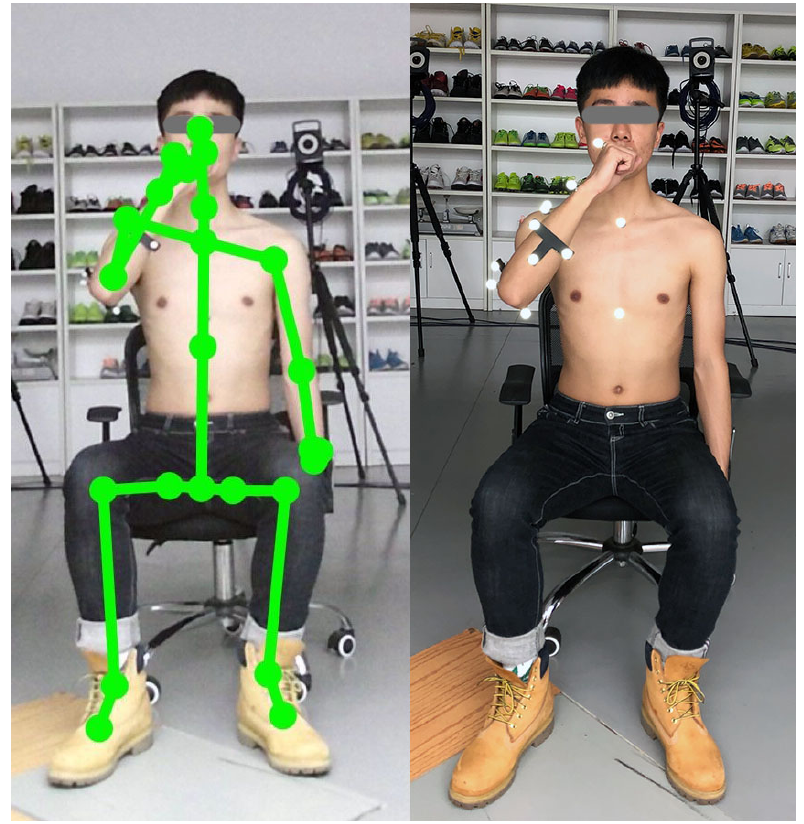
Figure 1. A subject performing a hand-to-mouth task. ( Left ) The subject with the Kinect Skele- ton derived from Kinect SDK. ( Right ) The subject with reflective markers attached to anatomical